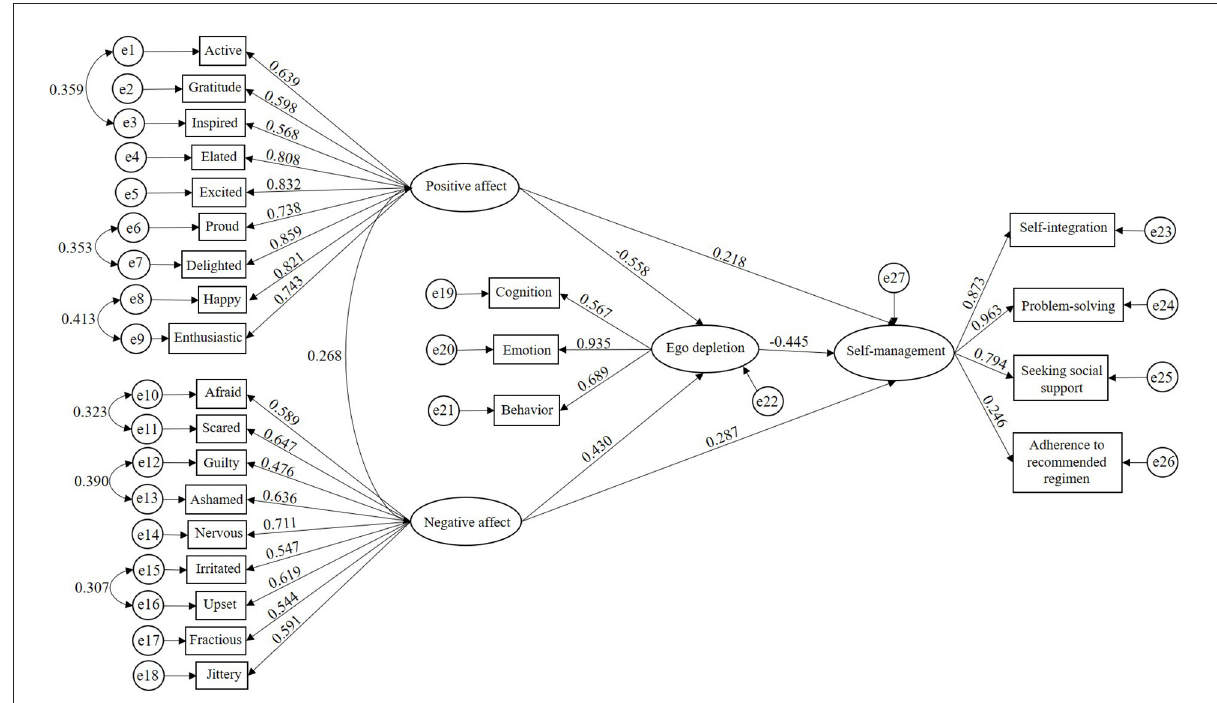
FIGURE1 Structural equation model of the mediating effect of ego depletion on the relationships between positive and negative affect and self-management among patients with early CKD ( n = 383). All factor loadings were significant at the p < 0.05 level.